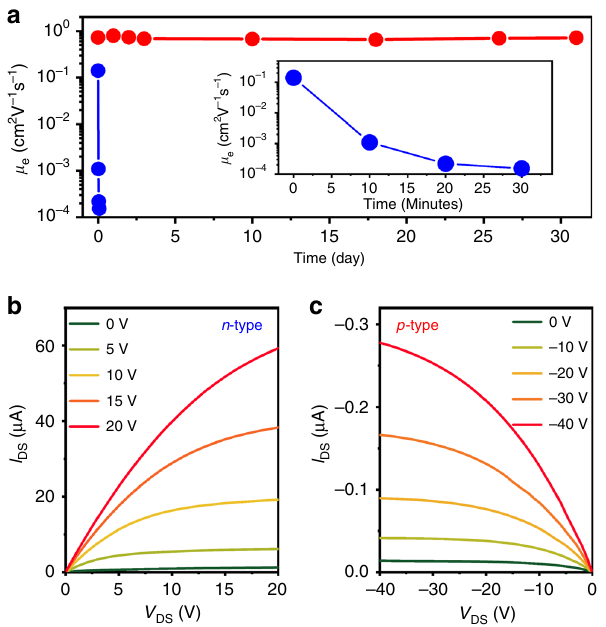
Fig. 3 Effects of the ALD treatment on FET stability and performance. a Measurements of air stability of charge-transport characteristics (inferred from changes in the electron mobility) of n -channel devices before (blue circles) and after (red circles) encapsulation in Al 2 O 3 using atomic layer deposition (ALD). Inset is the magni fi ed view of the fi rst 30 min of the